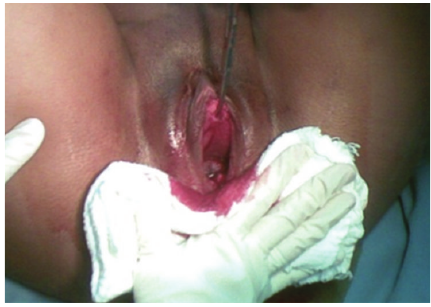
Figure 4: Delivery following resection of the septum. Note the anterior extremity of the septum is still clamped (sutures performed following